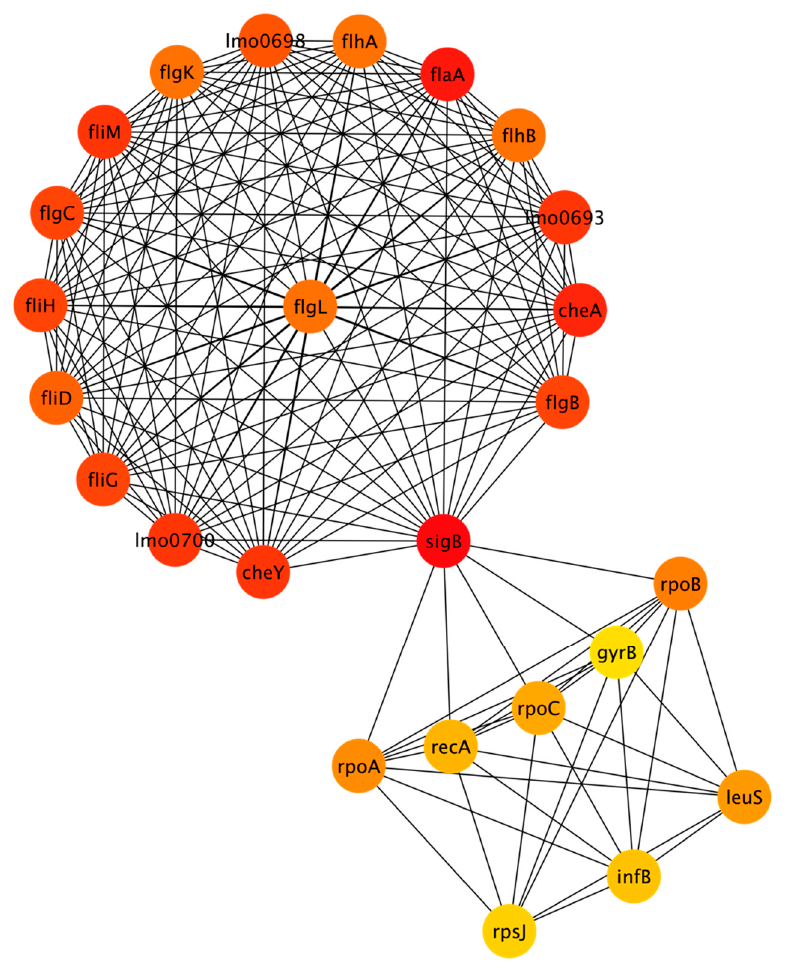
Figure 4. Antibiotic resistance network depicting top 25 nodes (refer to Table S3 for additional in- formation about each